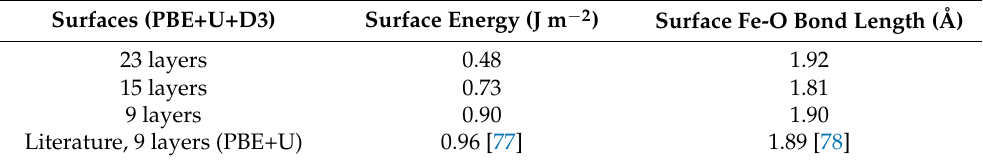
Table 2. Fe 3 O 4 (001) surface energy and Fe-O bond length of surface tetrahedrally coordinated Fe, for 23-layer, 15-layer, and 9-layer slabs calculated at PBE+U+D3 level of theory and compared to previous surface study using